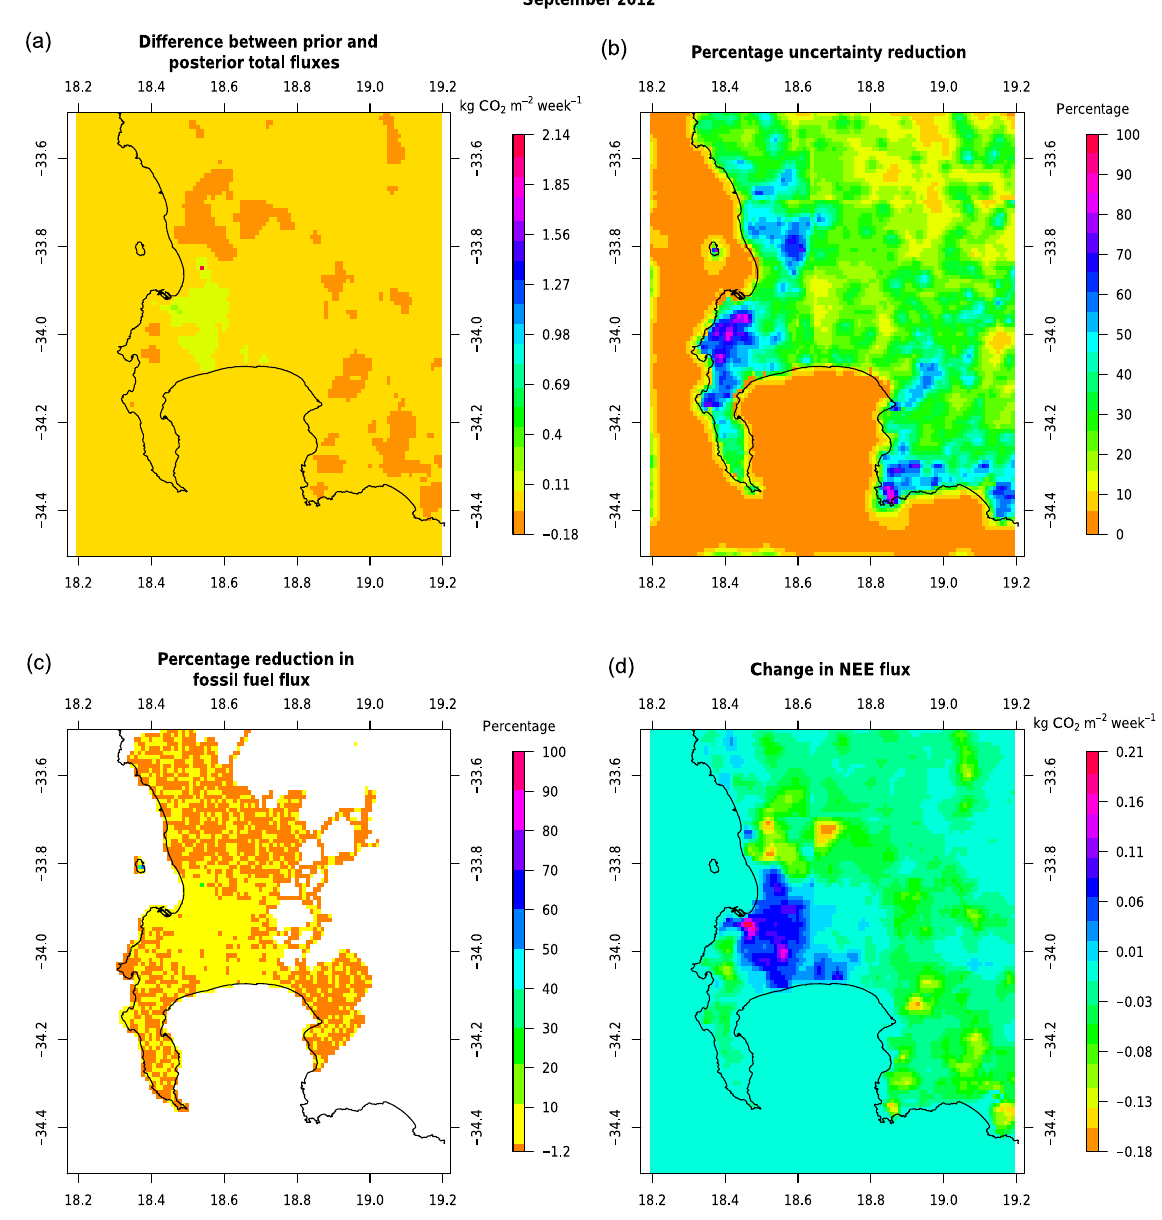
Figure 13. (a) Differences between the prior and posterior total flux estimates (kg CO 2 m − 2 week − 1 ) for September 2012 (prior – posterior). (b) Percentage reduction in the standard deviation of the flux estimate from prior to posterior. (c) Percentage reduction in the fossil fuel flux estimates from prior to posterior. (d) Differences in the biogenic flux estimates between prior and posterior estimates (prior – posterior) (kg CO 2 m − 2 week − 1 ), with negative values indicating posterior CO 2 fluxes were made more positive by the inversion compared with the prior estimates. Extent: between 34.5 and 33 . 5 ◦ S and between 18.2 and 19 . 2 ◦